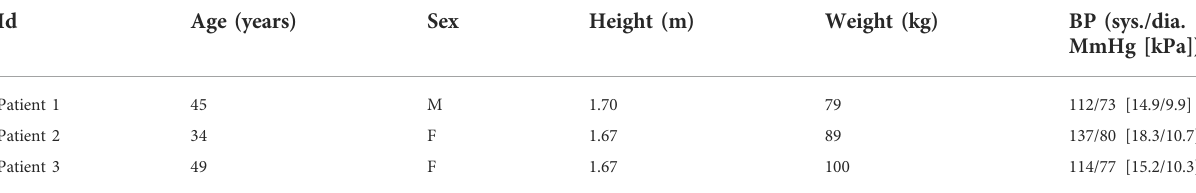
TABLE 1 Baseline patient characteristics including age, sex (M = male, F = female), height, weight, and resting systolic (sys.) and diastolic (dia.) blood pressure